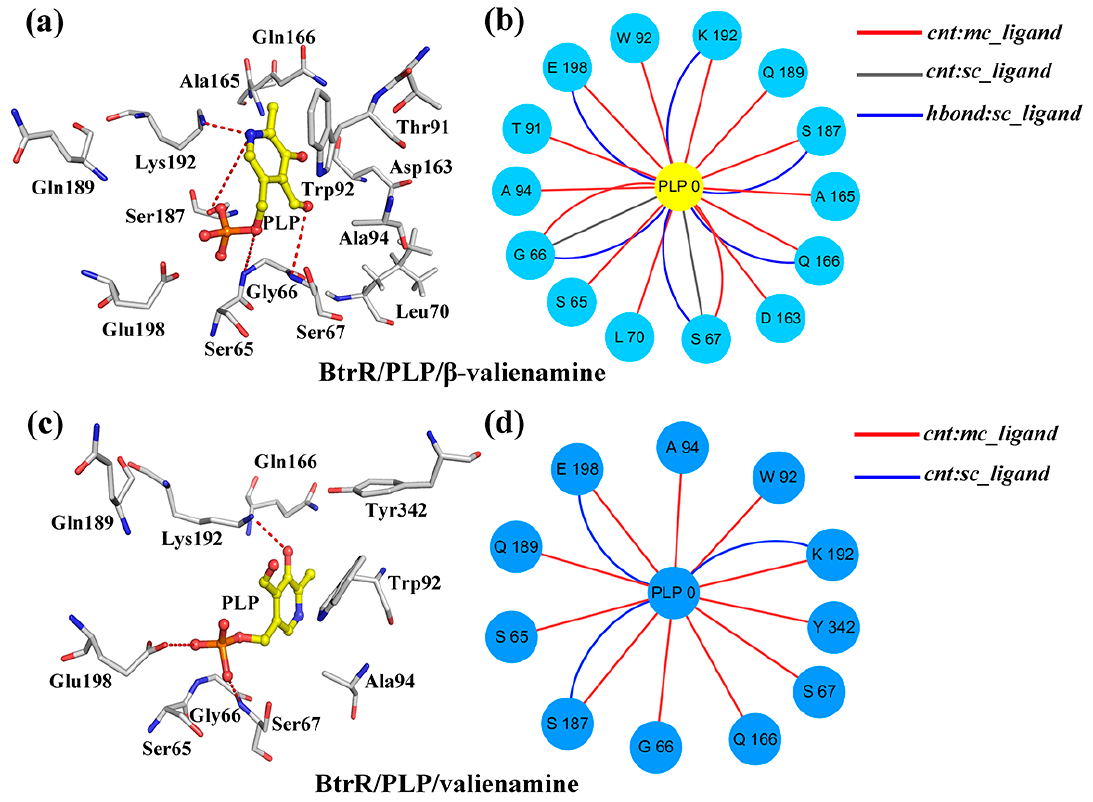
Figure 4. Two-dimensional view and three-dimensional view of the subnetwork of the PLP for BtrR. ( a , b ) The subnetwork of PLP and BtrR in the BtrR/PLP/ β -valienamine complexes. ( c , d ) The subnetwork of PLP and BtrR in BtrR/PLP/valienamine complexes. The interaction types: interatomic contact (cnt):ligand-sc are highlighted in light gray, ligand-mc are highlighted in red, and hbond:ligand-sc is highlighted in blue.